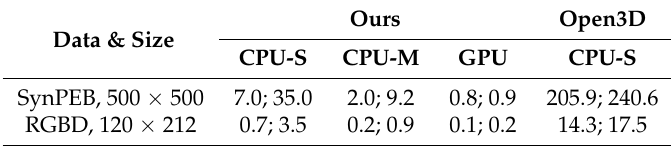
Table 12. Execution timing (ms) for one and five iterations of Laplacian